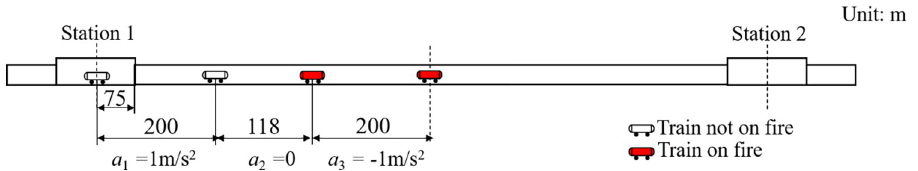
Fig 8. Scenario of a moving fire source.